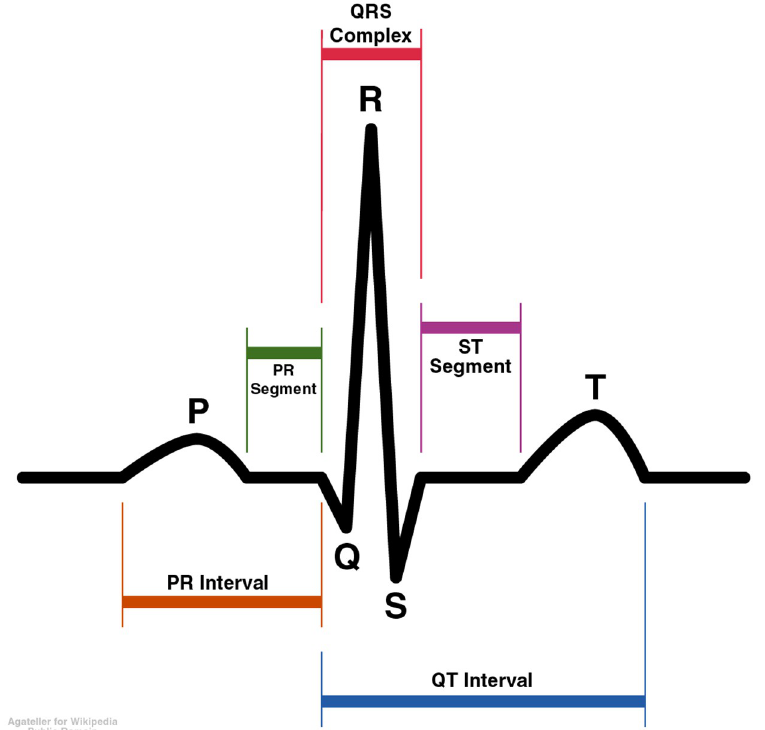
Fig 2. Idealized ECG heartbeat with waves